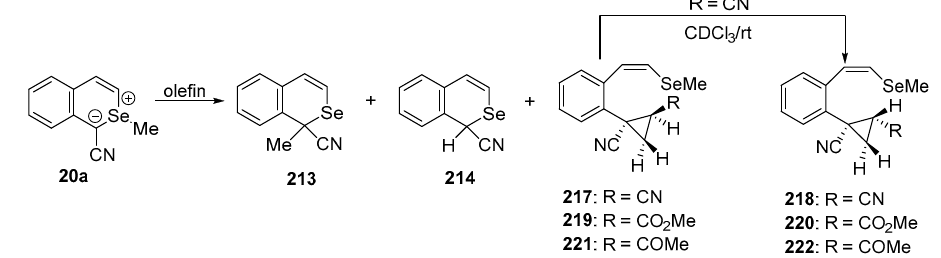
Table 15. Reactions of selenanaphthalene 20a with electron-deficient olefins. Entry Olefins (equiv.)